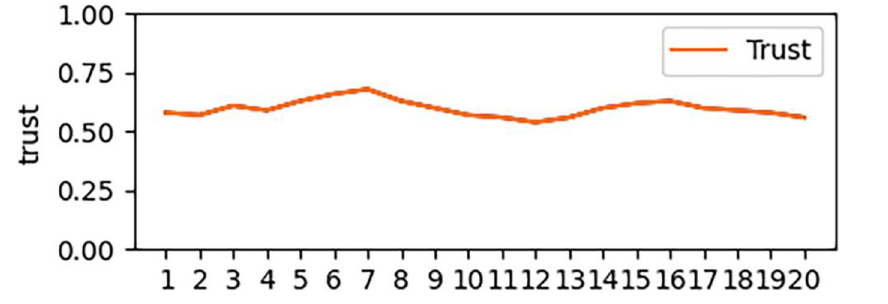
Fig 2. Stable entity trust